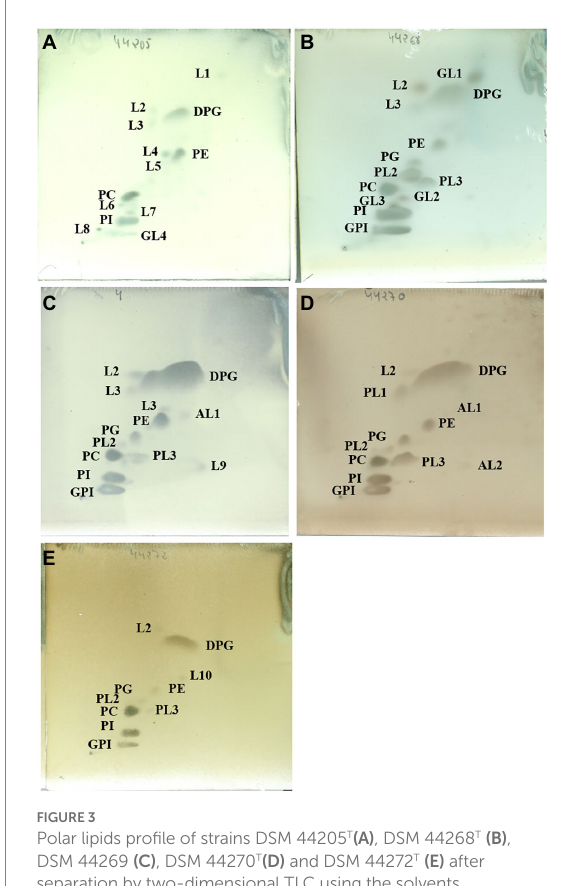
FIGURE 3 Polar lipids profile of strains DSM 44205 T (A) , DSM 44268 T (B) , DSM 44269 (C) , DSM 44270 T (D) and DSM 44272 T (E) after separation by two-dimensional TLC using the solvents chloroform:methanol:water (65:25:4; v:v:v) in the first dimension and chloroform:methanol:acetic acid:water (80:12:15:4; v:v:v:v)